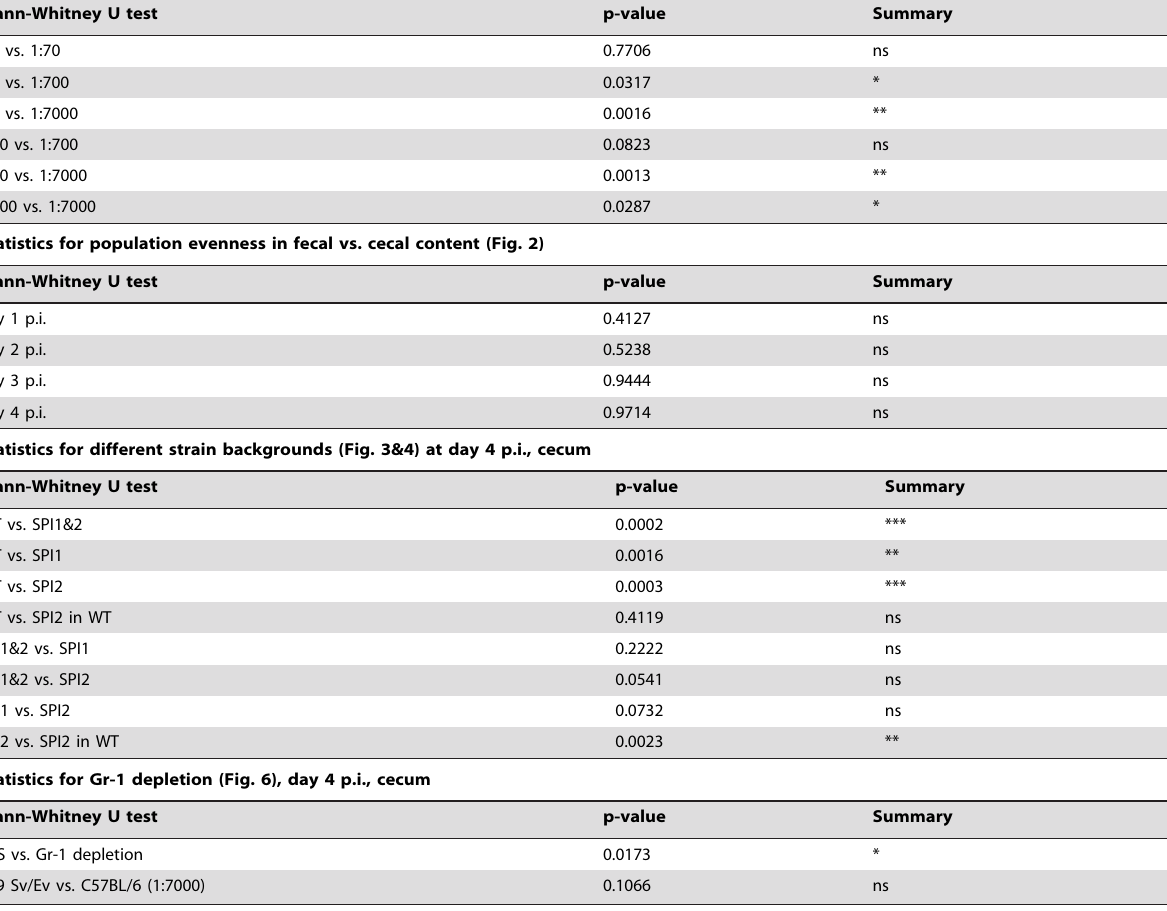
Table 1. Statistics on population